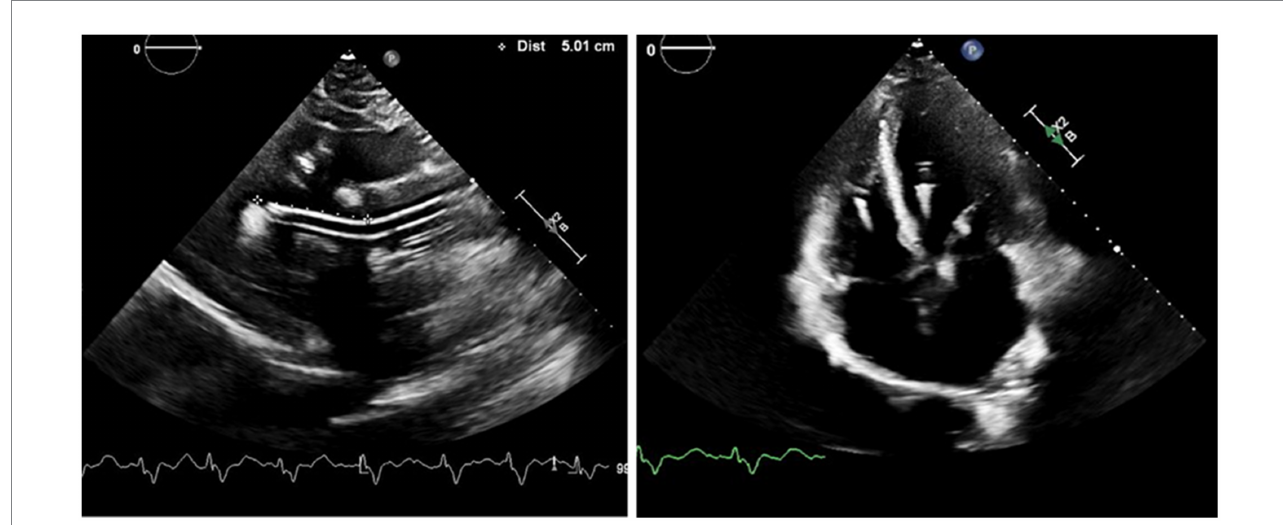
FIGURE 1 Positioning of the Impella 5.5: The bending portion of Impella pump head will be on the level of aortic valve with the tip pointing away from the posterior wall in the parasternal long axis view, and away from septum in the four chamber view. Impella position-related aortic insufficiency could be observed for patients with atherosclerotic aortic valve in the apical